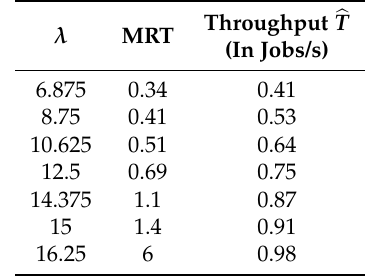
Table 2. Results recorded when executing the Dynamical Load-Balanced Scheduling (DLBS) scheme to examine the system throughput. MRT, Mean Response